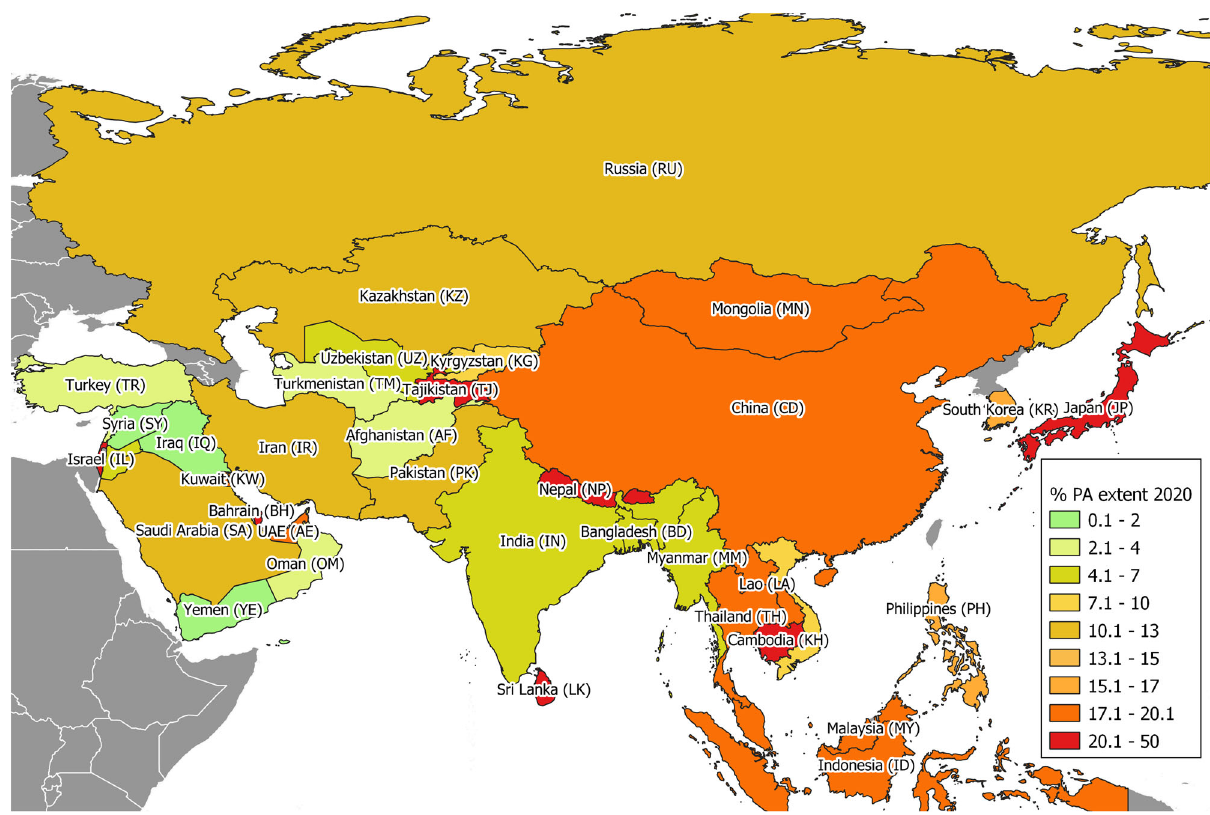
Fig. 1 Asian countries and the percentage of protected areas (PA) in 2020. The full and abbreviated names for all Asian countries analyzed in this study are shown. The map projected using WGS 84 EPSG: 4326 coordinate reference system.